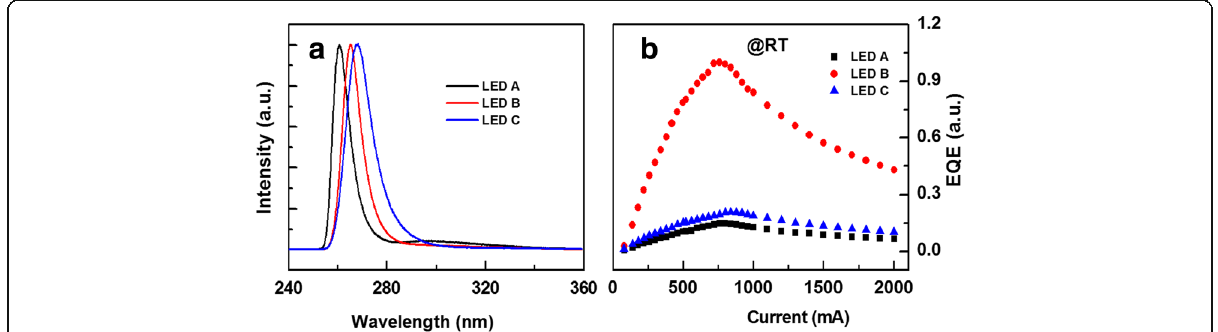
Fig. 1 a The RT EL spectra for LEDs A, B, and C under direct current of 100 mA. All the spectra were normalized to the band-to-band emission. b The relative EQE as a function of pulse